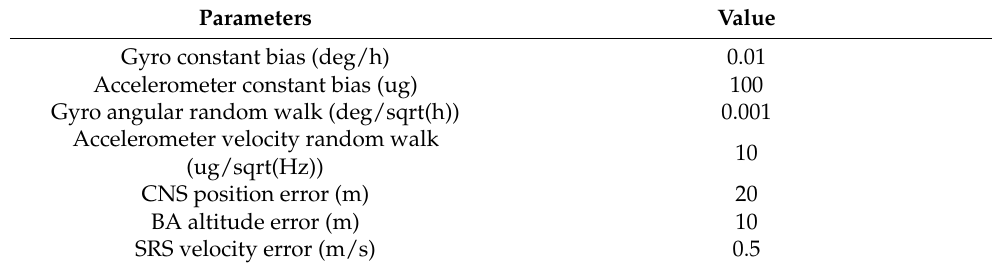
Table 1. Sensor rate settings.